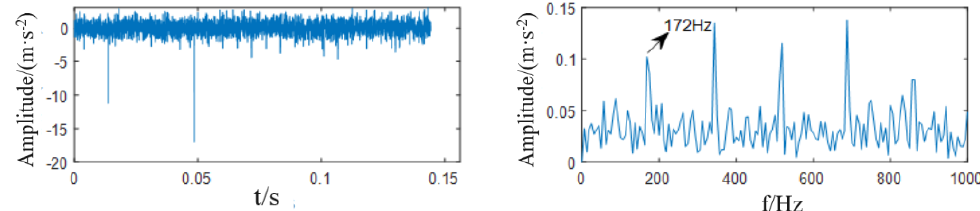
Figure 15. Time-domain diagram and envelope diagram of the experimental signal after inner ring fault enhancement.